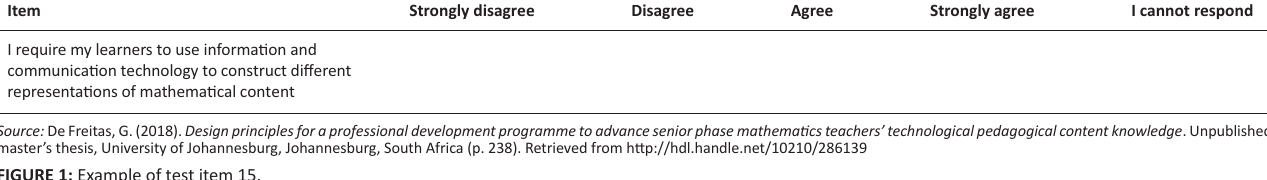
FIGURE 1: Example of test item